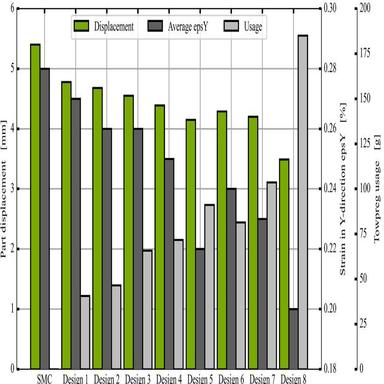
Numerically investigating the influence of grid-like structure with varied towpreg spacing, layer and layout on the part displacement and the average strain (epsY) in the part width direction within ROI 1 concerning towpreg usage.